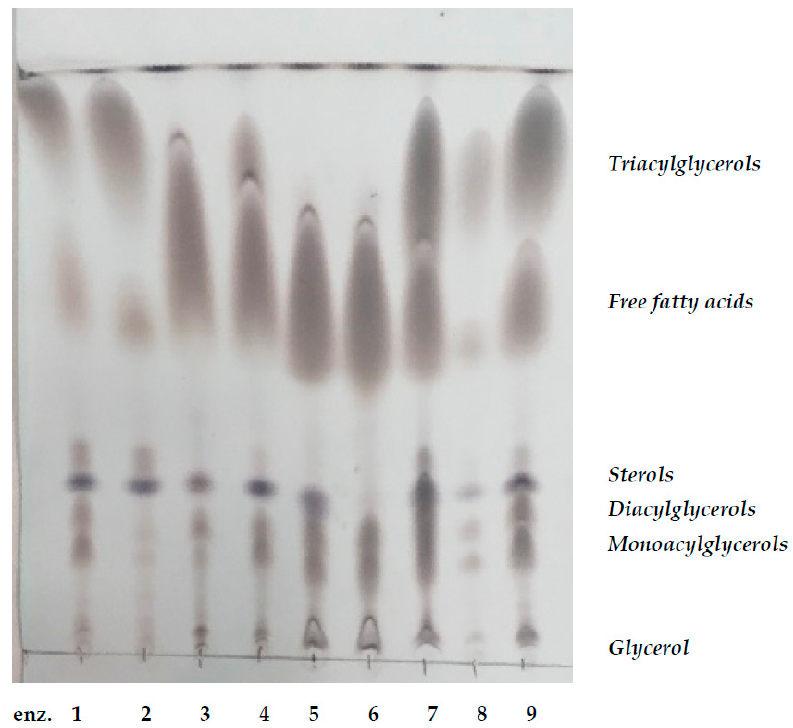
Figure 1. TLC chromatography of samples of animal fat hydrolyzed by di ff erent lipases. Enz., enzyme. Numbers—the numbers of the individual enzymes are introduced in Table